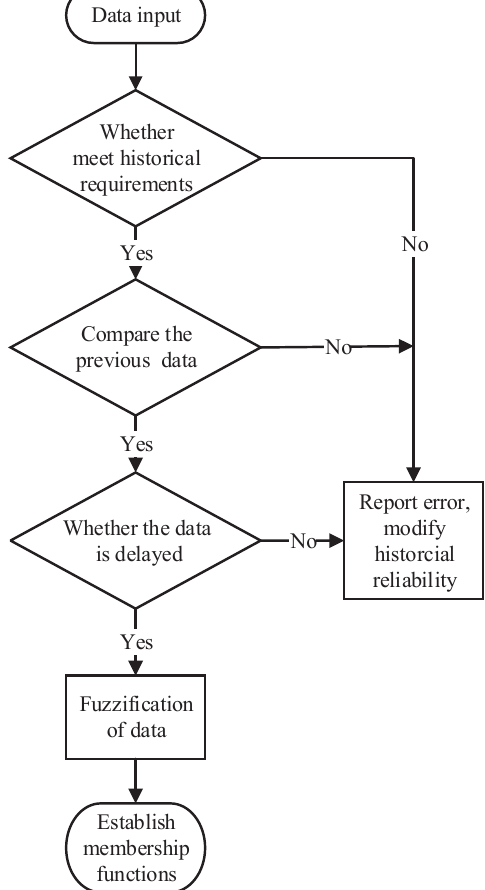
Figure 5. The architecture of the improved onboard safety computer